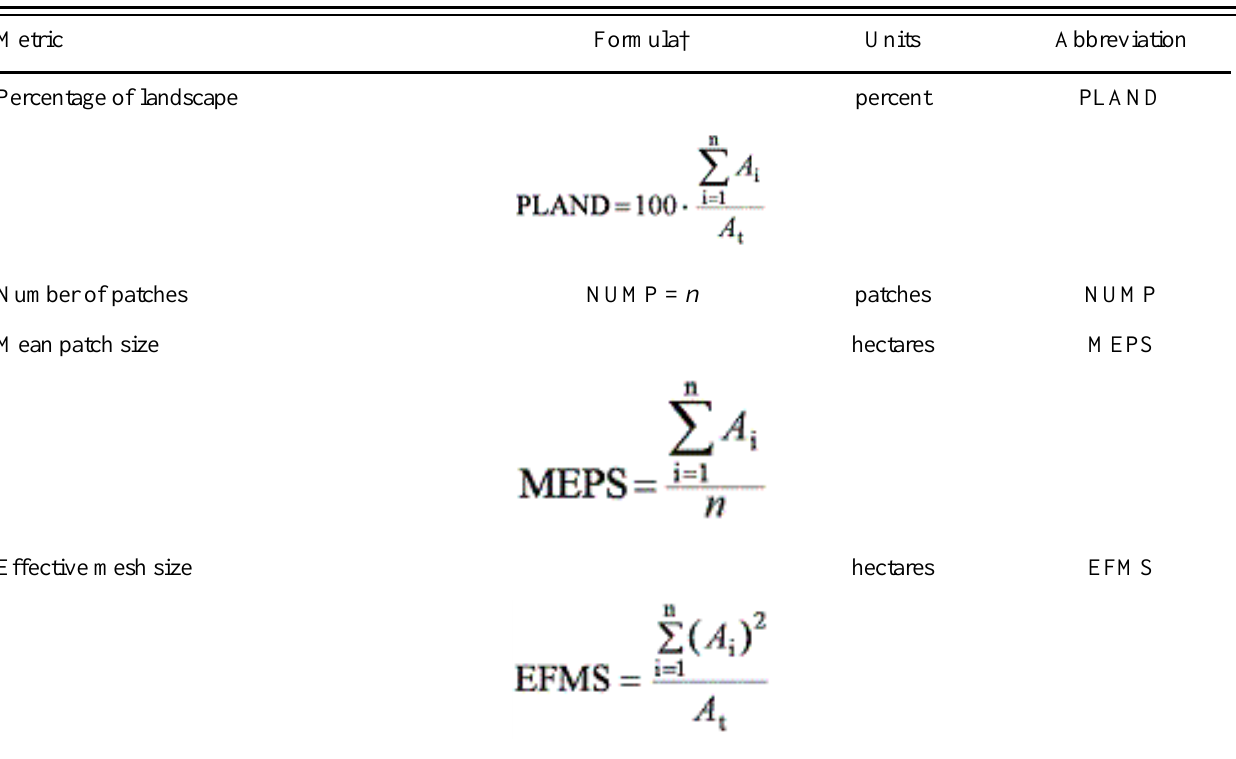
Table 1. The four landscape metrics